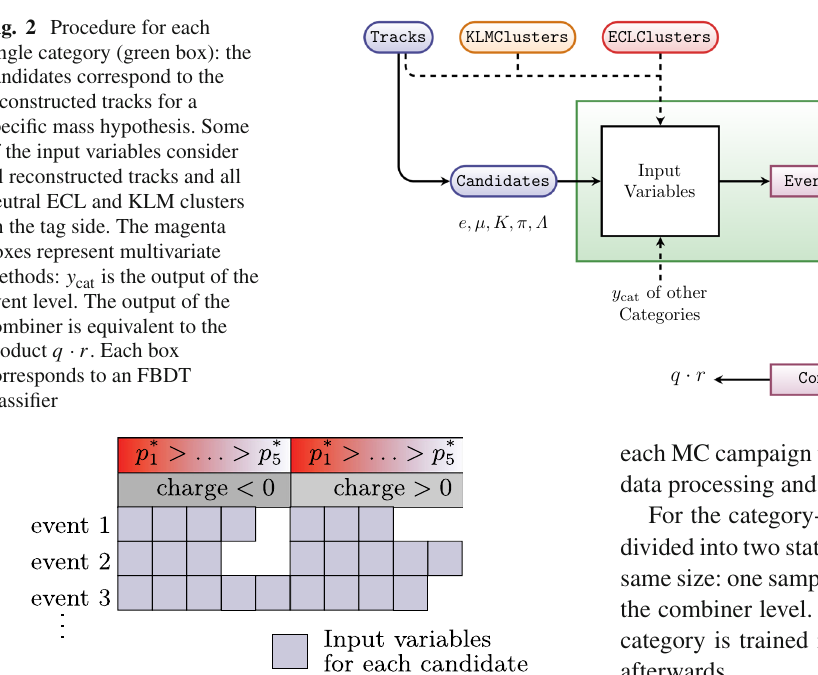
Fig. 3 Scheme of the input information for the MLP in the deep- learning flavor tagger. The tracks on the tag side are sorted into two groups according to their electric charge and ranked according to their momentainthe Υ ( 4S ) frame.Thetop5tracksineachgroupareselected as candidates. The MLP receives input variables for each